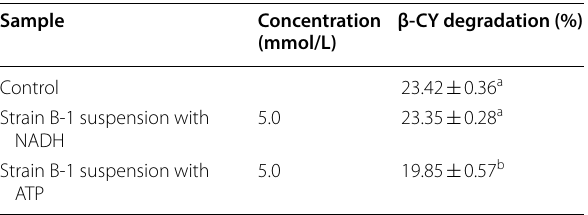
Data are presented as mean standard deviation of three replicates; the ± standard deviations are within 5% of the mean. Different letters indicate significant differences ( p <